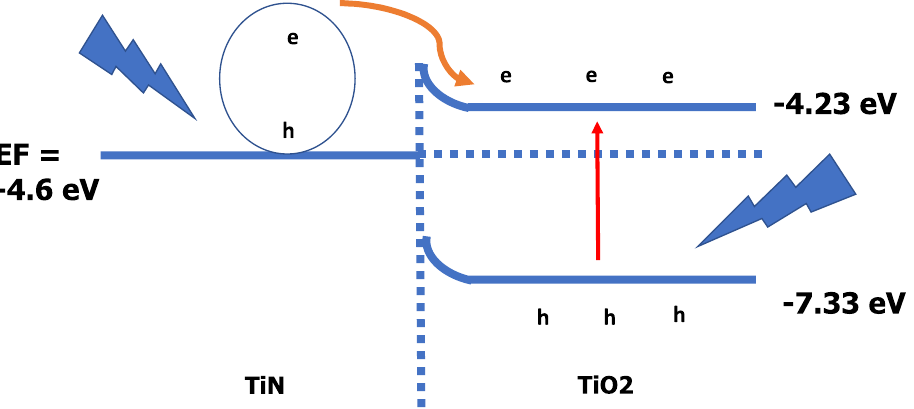
Figure 9. Energy level diagram showing the transportation of charge carriers for TiO 2 /TiN